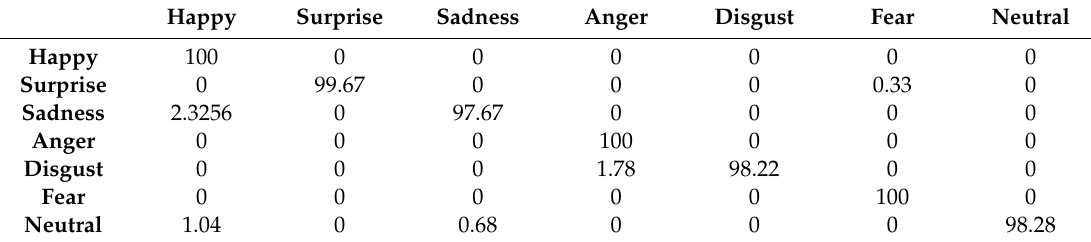
Table 3. Confusion matrix of the CK + dataset (SVM).